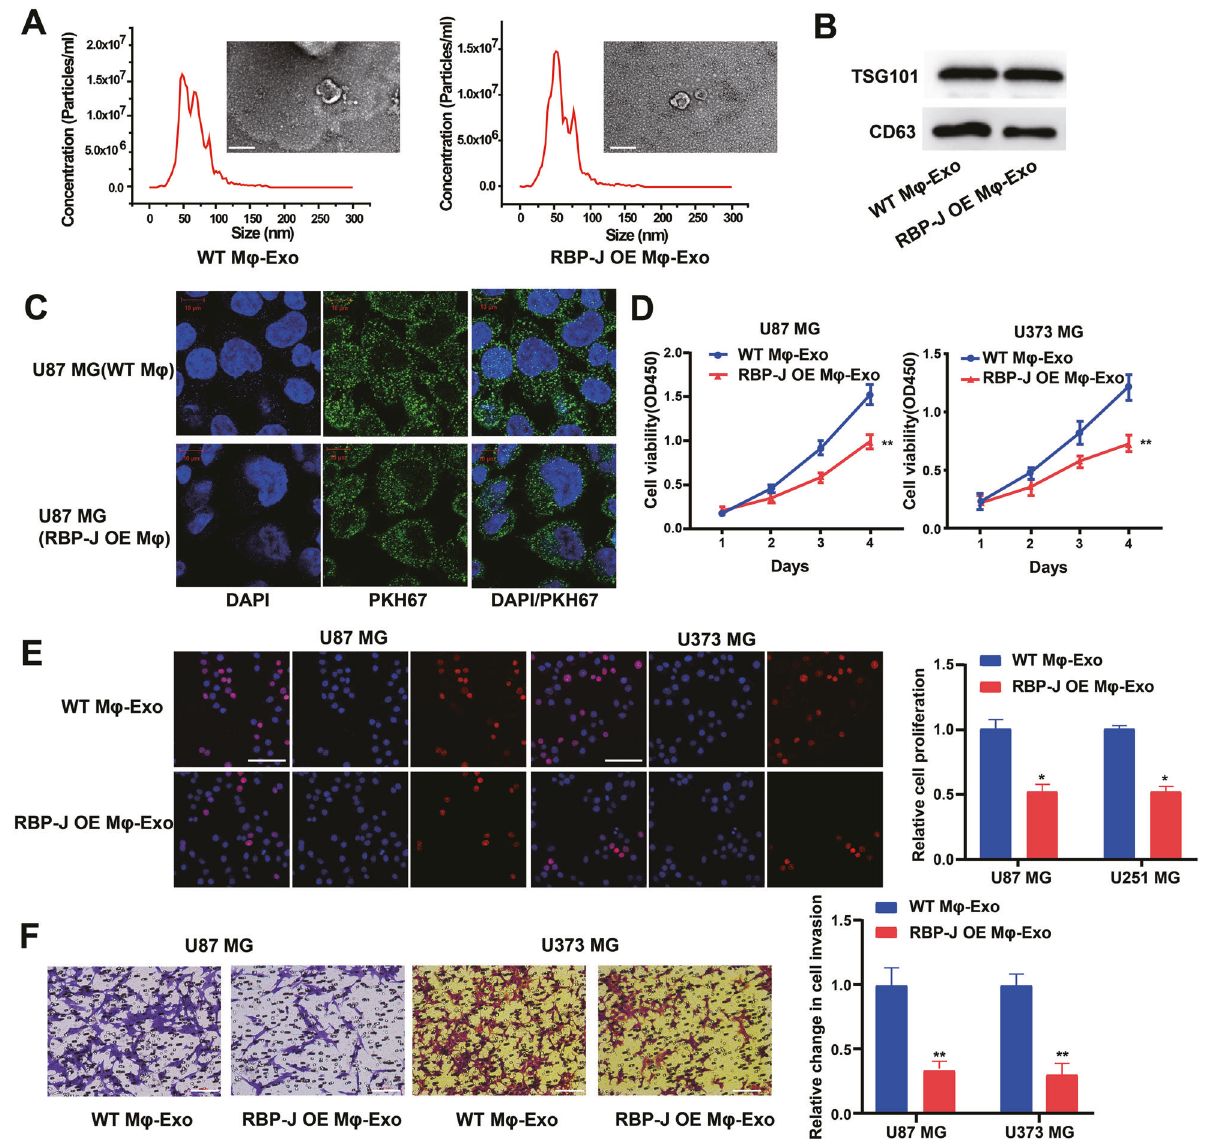
Fig. 2 Exosomes derived from RBP-J overexpressed macrophages inhibit proliferation and invasion of glioma cells. A Exosomes isolated from WT THP-1 derived macrophages (WT M φ -Exo) and RBP-J -overexpressed macrophages ( RBP-J OE M φ -Exo) imaged by transmission electron microscopy (TEM) and their size distribution were measured using NTA. Scale bar = 50 nm. B Levels of exosome markers CD63 and TSG101 in WT or RBP-J OE M φ -Exo were determined by Western blotting. C WT M φ -Exo or RBP-J OE M φ -Exo were labeled with PKH67; green represents PKH67, and blue represents nuclear DNA staining by DAPI. U87 MG cells were incubated with WT M φ -Exo or RBP-J OE M φ -Exo for 3 h. D , E Cell proliferation in glioma cell lines U87 MG and U373 MG treated with WT M φ -Exo or RBP-J OE M φ -Exo was assessed by CCK-8 ( D ) and EdU assay ( E ). F Transwell invasion assay is performed to indicate cell invasion (bar = 100 μ m). All experiments were performed three times. * P < 0.05 and ** P < 0.01 for statistical